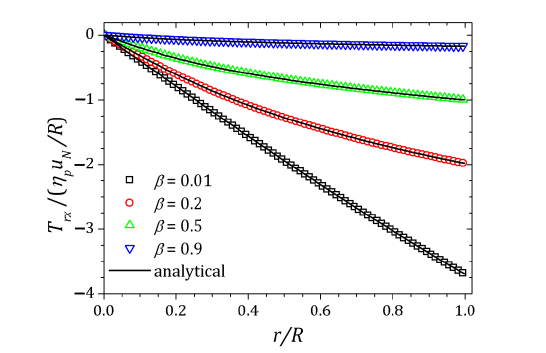
Figure 2. Velocity field for a PTT flow in a pipe.